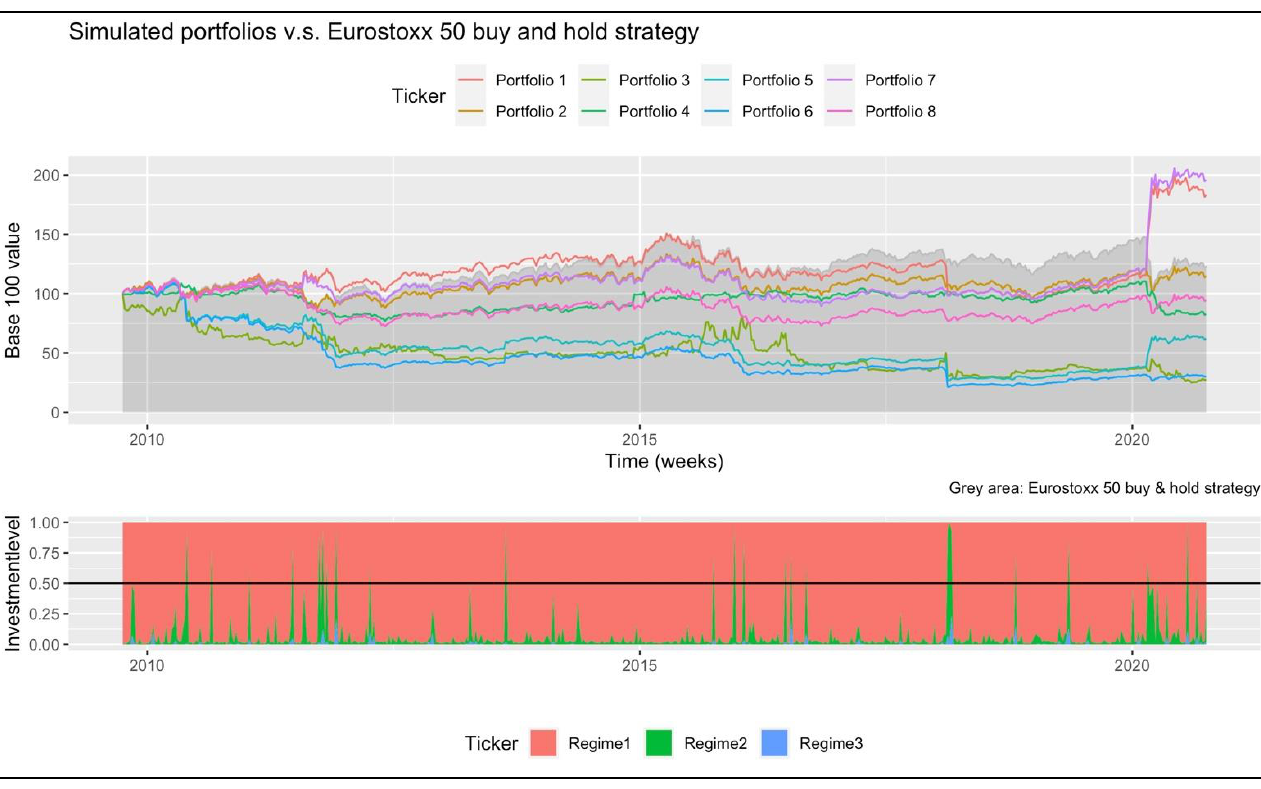
Figure 7. Weekly historical performance of the eight simulated portfolios of Table 2 with smoothed ( ω i = ξ s = i , T + 1 ) weighting method. It presents the historical 9 July 2009 Base 100 value of the eight simulated portfolios (lines) against a buy-and-hold ESTOXX50 strategy (grey area). The historical three-regime MS-GARCH regime-specific forecasted smoothed probabilities ( ξ s = i , T + 1, t ). Methodological note: The eight simulated portfolios include the impact of a monthly stock-trading fee of 0.8% in the mean ESTOXX50 position plus 10% VAT.